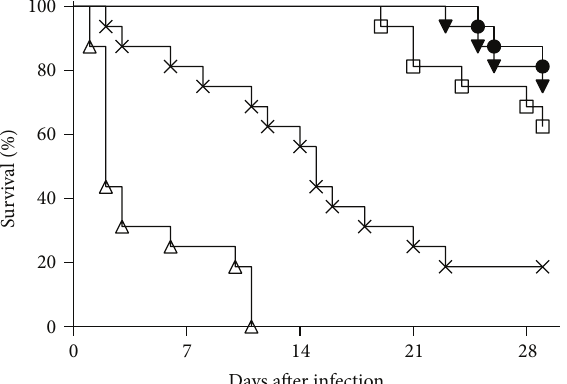
Figure 2: Survival of vaccinated mice following challenge with B. pseudomallei K96423. Mice were vaccinated three times at two-week intervals with 10 𝜇 g of either the TetH c -LPS conjugate ( ∙ ), LPS alone ( ◻ ), a mix of unconjugated LPS and TetH c ( 󳶃 ), TetH c only ( Δ ), or PBS ( x ) and challenged five weeks after the final vaccination with approximately 40 MLD of B. pseudomallei K96243. The data from two studies is combined in this figure with survival curves analysed by a stratified logrank test. We found no evidence ( 𝑃 > 0.05 ) for cross experimental variation in any vaccine group other than the TetH c group where animals survived less well in the second experiment ( 𝑃 < 0.05 ). All of the vaccine containing B. pseudomallei LPS offered significant protection compared to the unvaccinated control ( 𝑃 < 0.001 , in all cases) and the TetH c treated group ( 𝑃 < 0.001 , in all cases). We observed no statistical difference between the groups vaccinated with conjugate, LPS, or the mix of TetH c and LPS ( 𝑃 > 0.05 , in all